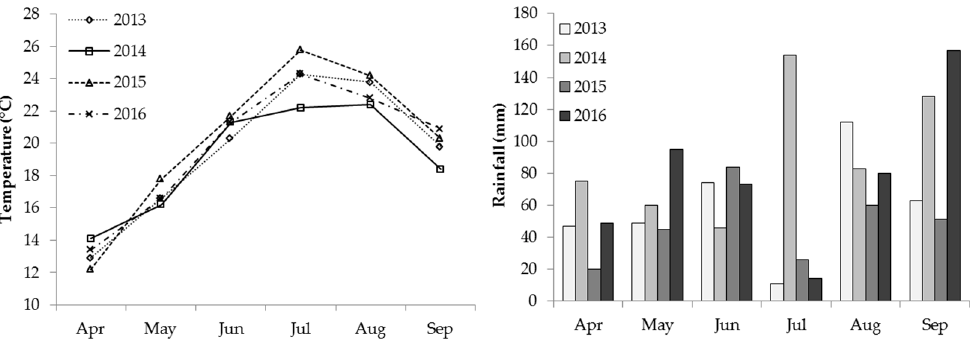
Figure 1. Seasonal patterns of mean air temperature and monthly rainfall in seasons 2013–2016.